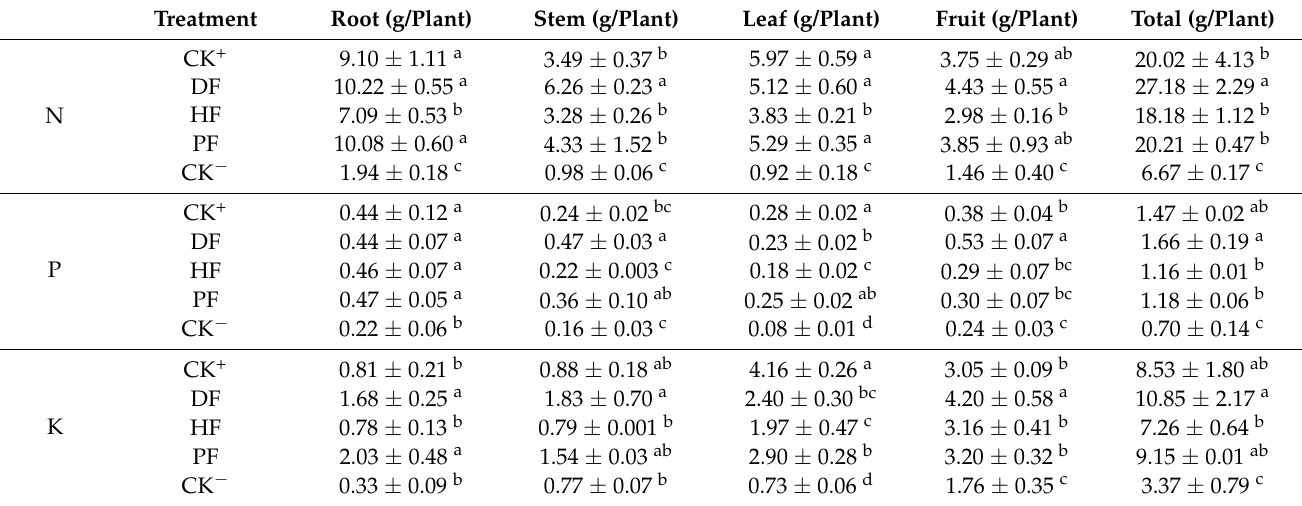
Figure 1. Growth of citrus plants under different fertilization approaches: ( A ) Stem diameter, ( B ) tree height, ( C ) dry matter and ( D ) medium- and micro- nutrients. The data are presented as mean ± SD, n = 3.Different letters indicate significant differences at p < 0.05, Duncan’s test. Table 1. NPK contents in plant tissues under different fertilization approaches.